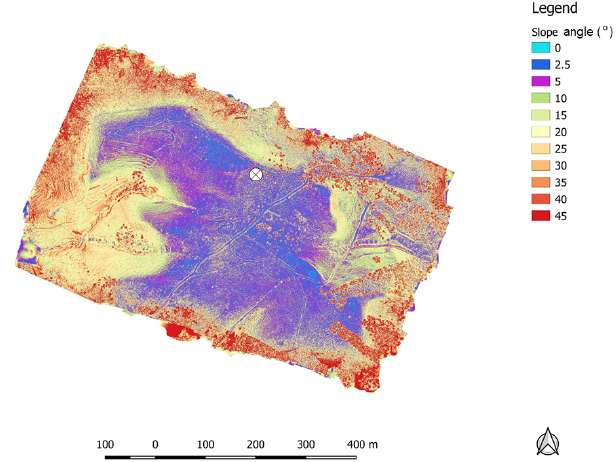
Figure 1. Slope angle map derived from aerial photography of the burnt area surrounding the flux tower. The imagery was acquired on 18 July 2018, using the standard RGB camera mounted on a DJI Phantom 3